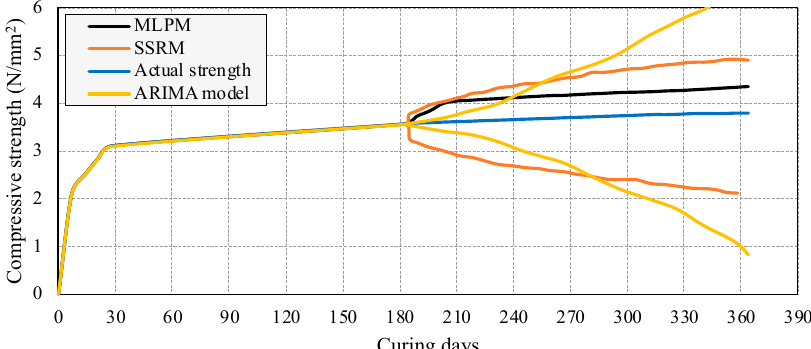
Figure 10. Comparison among three models for 180-day input data.